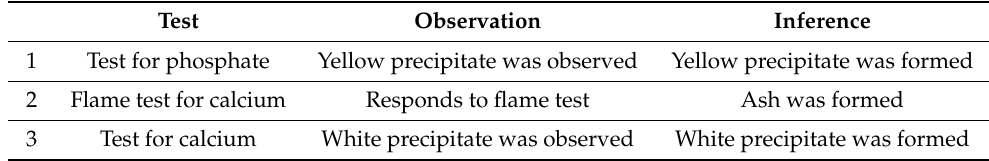
Table 1. Identification tests for beta tricalcium phosphate.